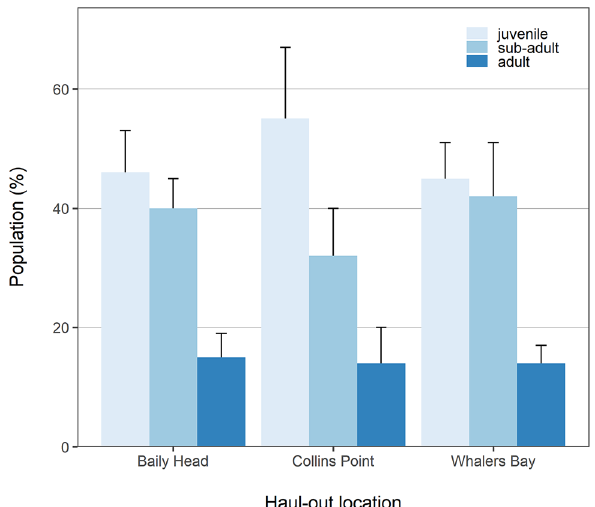
Figure 2. Demographic structure of the male Antarctic fur seal at haul-outs in Deception Island in early March 2019. Vertical bars denote standard deviation of two samples. Total number of seals: Baily Head: 103, Collins Point: 281, Whalers Bay: